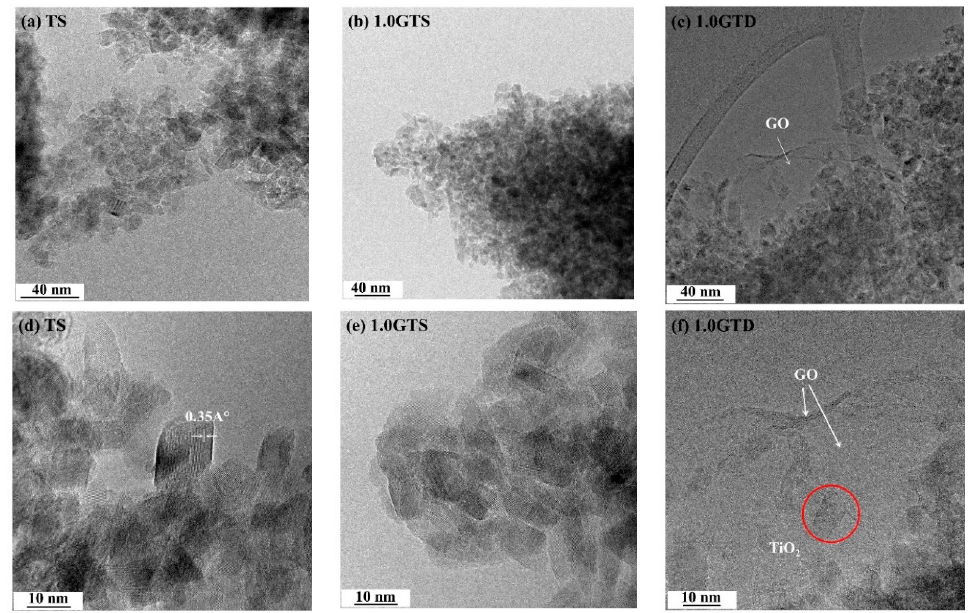
Figure 2. TEM images were taken at low (first row) and high magnification (second row) of the samples